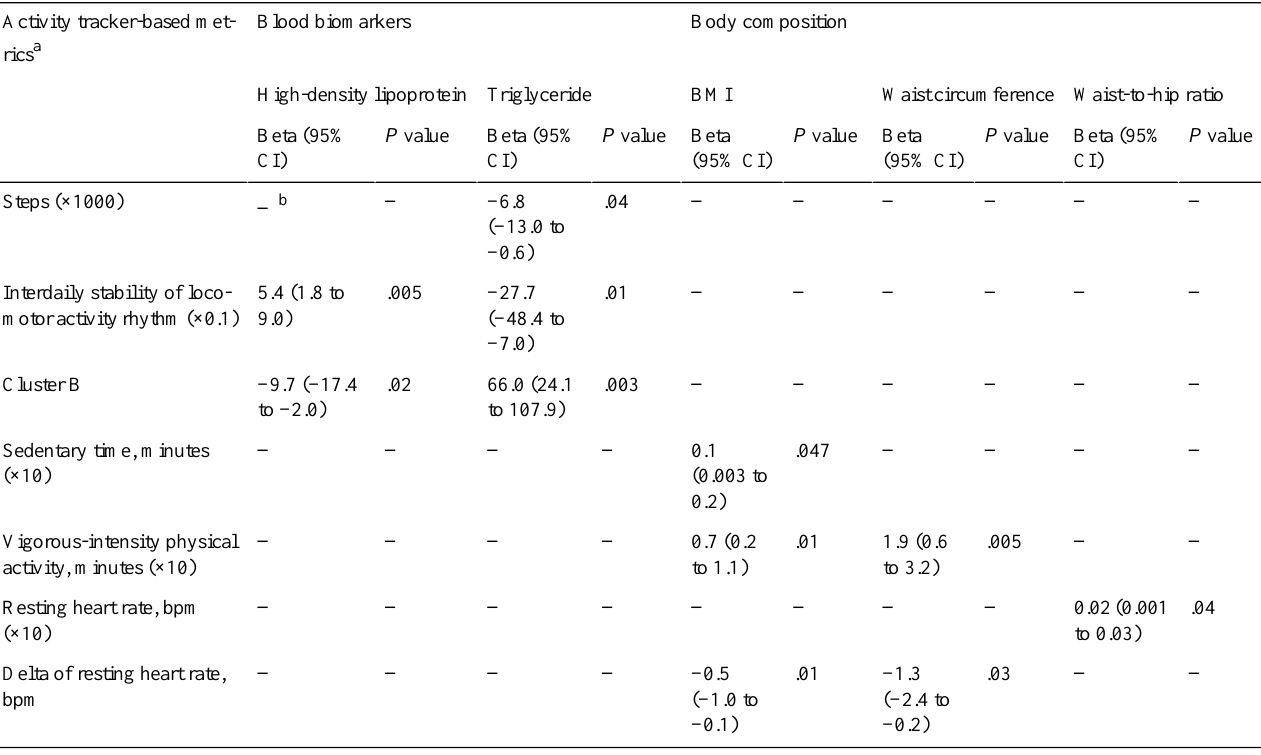
Table 3. Associations between wearable-based metrics of physical activity and common cardiometabolic disease risk markers.